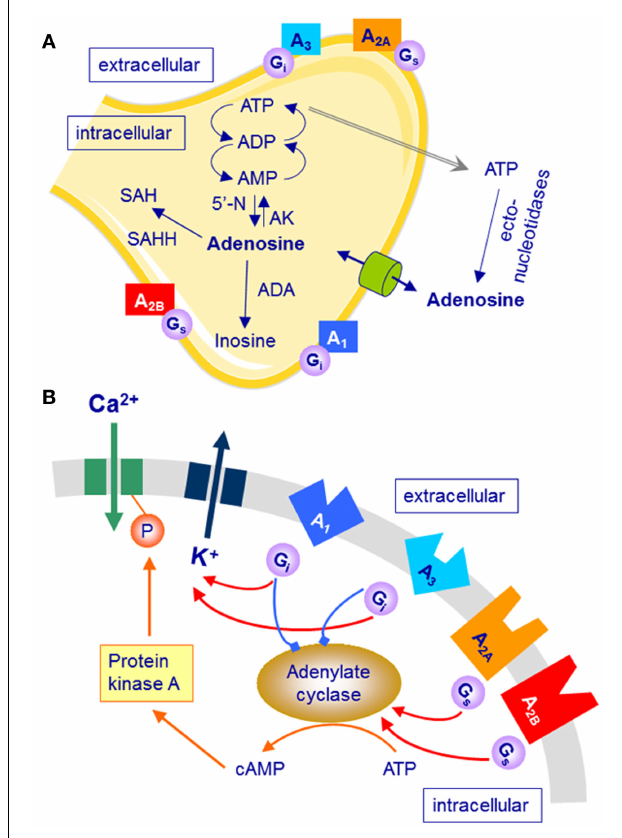
FIGURE 1 | Simplified schematic representation of adenosine formation, metabolism and transport, and G-protein coupled adenosine receptors (rectangles representingA 1 ,A 2A ,A 2B , andA 3 receptors). Only selected mechanisms and pathways are shown. (A) Neurons, astrocytes, and microglia cells can release adenosine and adenosine-tri-phosphate (ATP; gray arrow). All cell types express adenosine receptors, adenosine transporters (cylinder), and ecto-nucleotidases that convert ATP into adenosine. ADP, adenosine-di-phosphate; AMP, adenosine-mono-phosphate; SAH, S -adenosyl-homocysteine; 5 (cid:2) - N, 5 (cid:2) -nucleotidase; AK, adenosine kinase; ADA, adenosine deaminase; SAHH, S -adenosyl-homocysteine hydrolase. (B) Activation of adenosine receptors either inhibits (A 1/3 receptors) or stimulates (A 2A/2B receptors) adenylate cyclase and the cyclic AMP (cAMP)